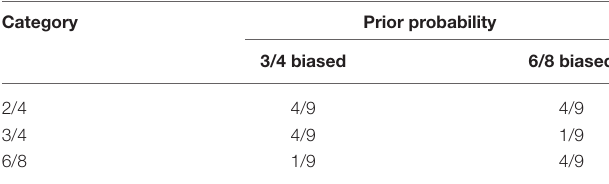
TABLE 1 | Prior probabilities of metrical categories used for simulating inferential